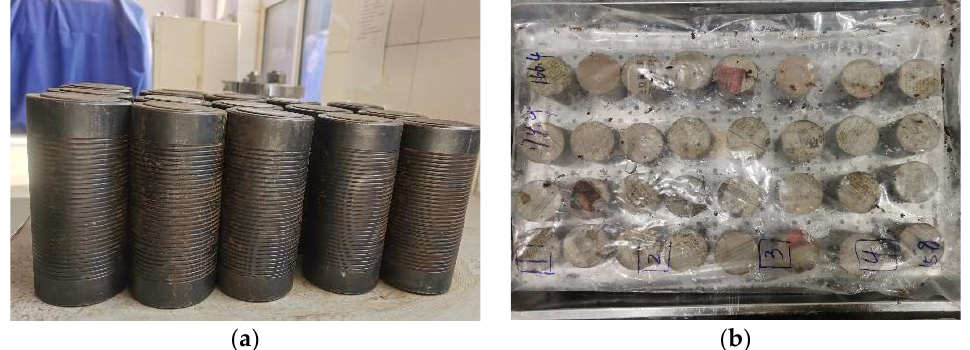
Figure 4. Samples preparation, ( a ) samples before demolding, ( b ) samples after demolding. After a while, the silt stabilized by TS was transferred into a plastic bag and kept in